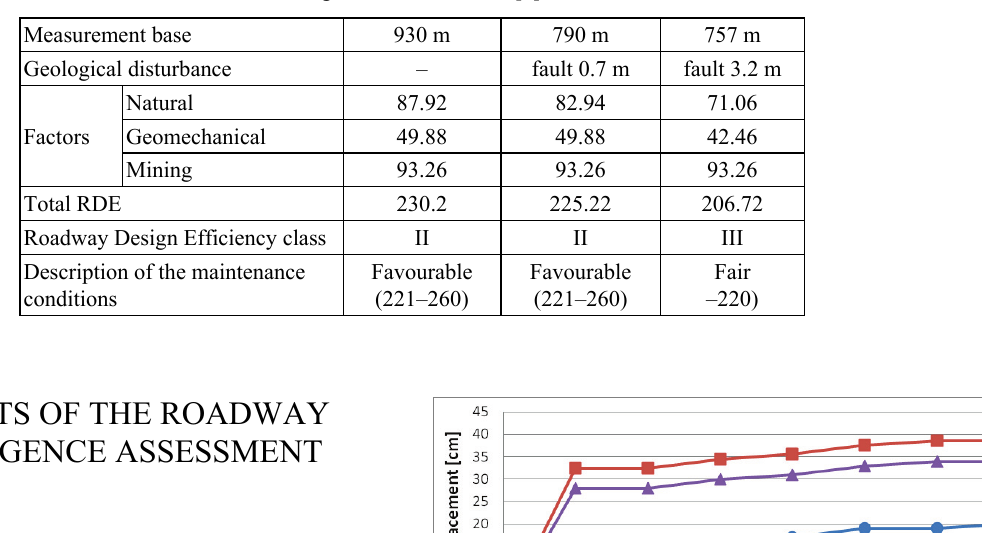
Table 1. The assesment of the D-2 maingate maintenance ego D-2, using RDE index, acc. to